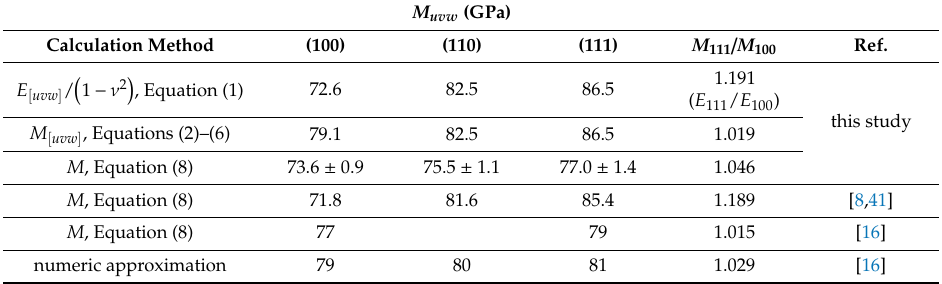
Table 4. Comparison of E IT values from literature and obtained in this study from the crystal orientation analysis. The values are given with the precision of the corresponding original publication. M uvw